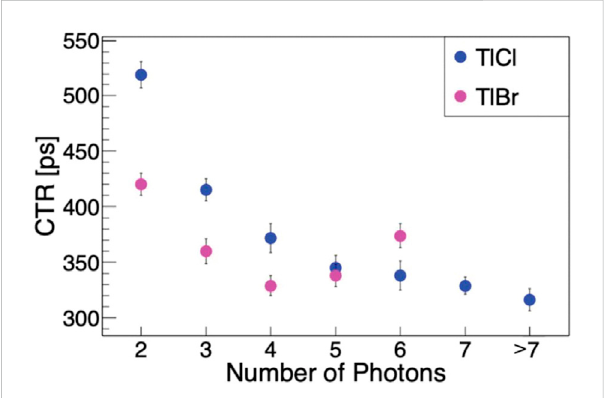
FIGURE 4 Comparison of the time resolution for TlBr (pink) and TlCl (blue) as a function of detected Cherenkov photons. Ⓒ [2020] IEEE. Reprinted, with permission, from [85].